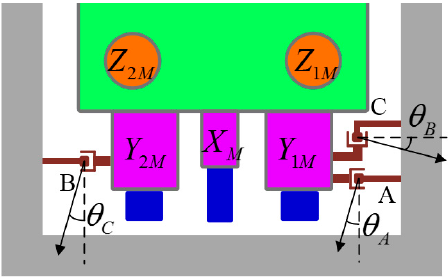
Figure 7. The angular assembly errors of the Hall sensor array.